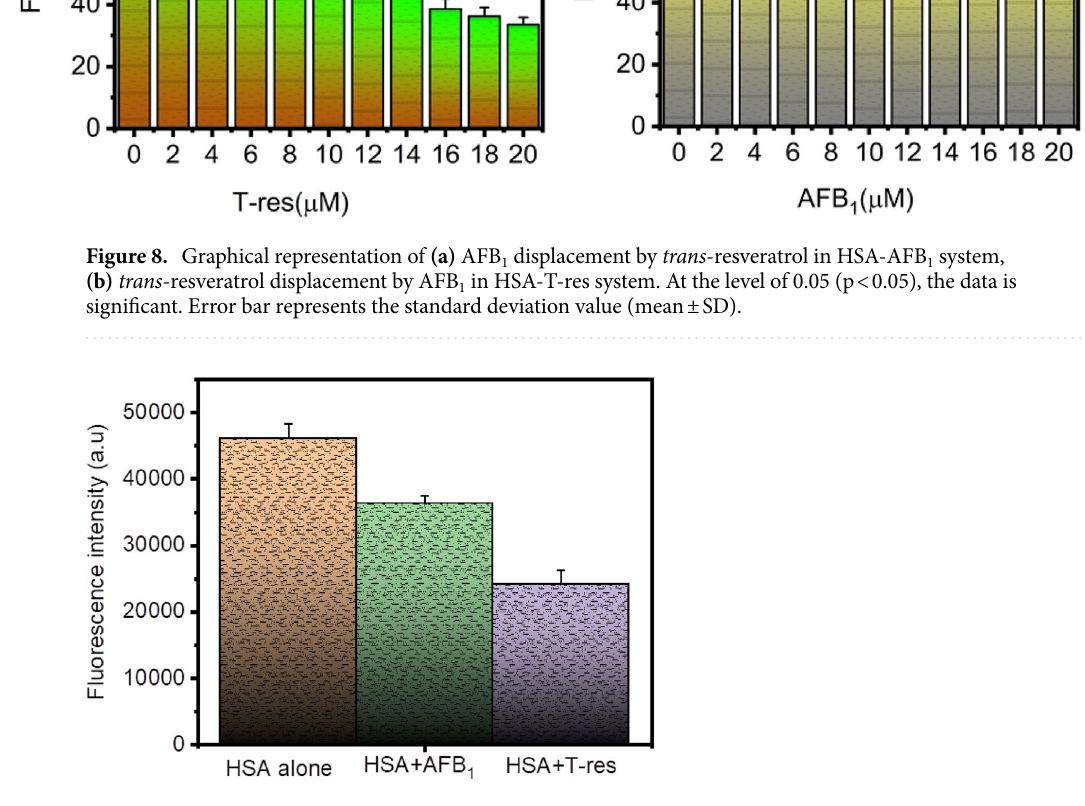
Figure 9. Graphical representation of the fluorescence intensity of HSA in the presence of trans -resveratrol and AFB 1 , excited at 280 nm. The concentration of HSA is 5 µM and the concentration of T-res = AFB 1 = 14 µM. At the level of 0.05 (p < 0.05), the data is significant. Error bar represents the standard deviation value (mean ± SD).